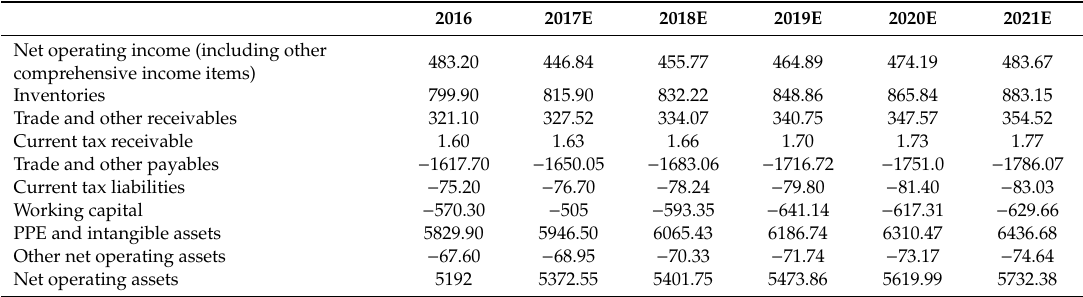
Table 1. Consistent Implementation of Free Cash Flow Valuation Model (FCFVM), Residual Earning Valuation Model (REVM) and Abnormal Earning Growth Model